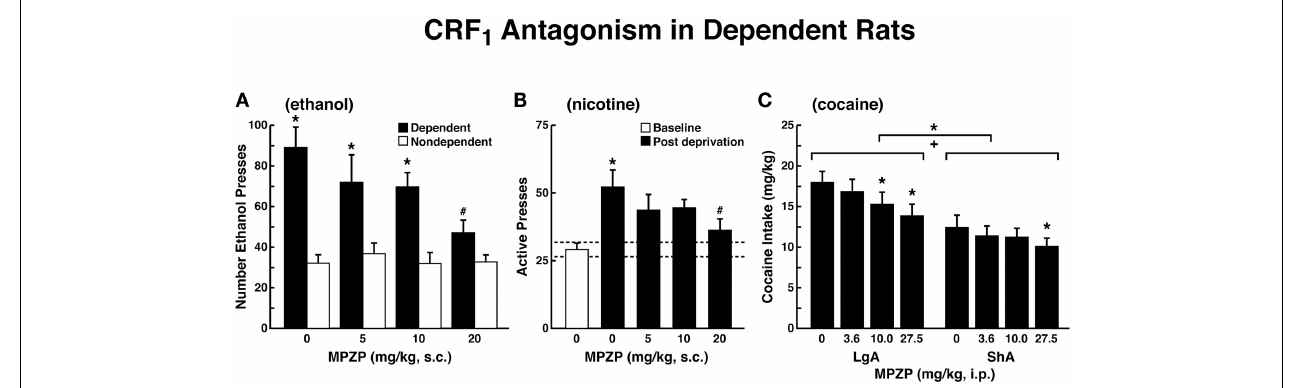
FIGURE 8 | Effects of CRF 1 antagonist on compulsive-like responding for drugs of abuse in rats with extended access to drug (A). The effect of the CRF 1 receptor antagonist MPZP on operant self-administration of alcohol in dependent and non-dependent rats.Testing was conducted when dependent animals were in acute withdrawal (6–8h after removal from vapors). Dependent rats self-administered significantly more than non-dependent animals, and MPZP dose-dependently reduced alcohol self-administration only in dependent animals.The data are expressed as mean + SEM lever presses for alcohol [taken with permission from Ref. (190)].